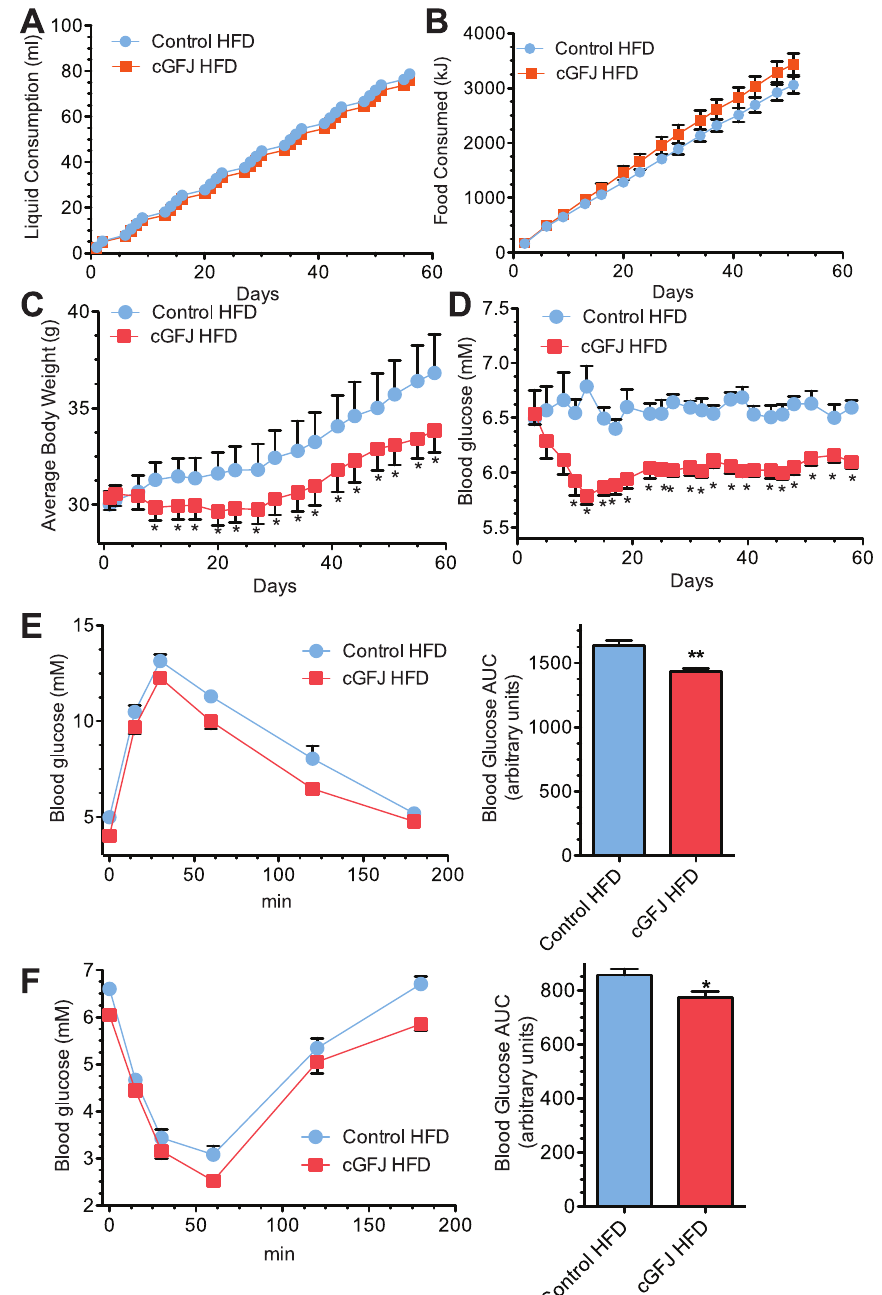
Figure 5. Impact of cGFJ on established diet-induced obesity. Mice were fed a HFD for 6 wk starting at 4 wk old. Animals were then divided randomly into control and GFJ groups (day 0) and HFD feeding was continued an additional 56 d: A) cumulative liquid consumption; B) cumulative food consumption; C) total body weights; D) blood glucose; E) GTT and AUC at week 6, P , 0.002; F) ITT and AUC at week 7, P , 0.03. A two tailed, unpaired t-test was used to determine statistical